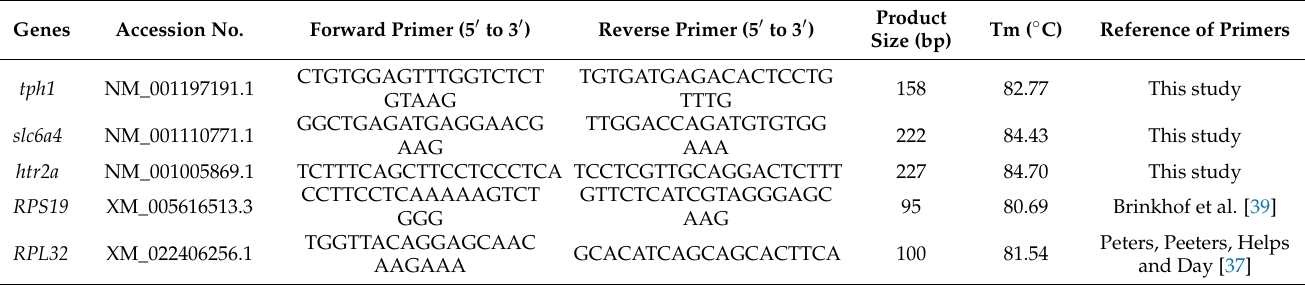
Table 1. Primers for qRT-PCR associating serotonin signaling